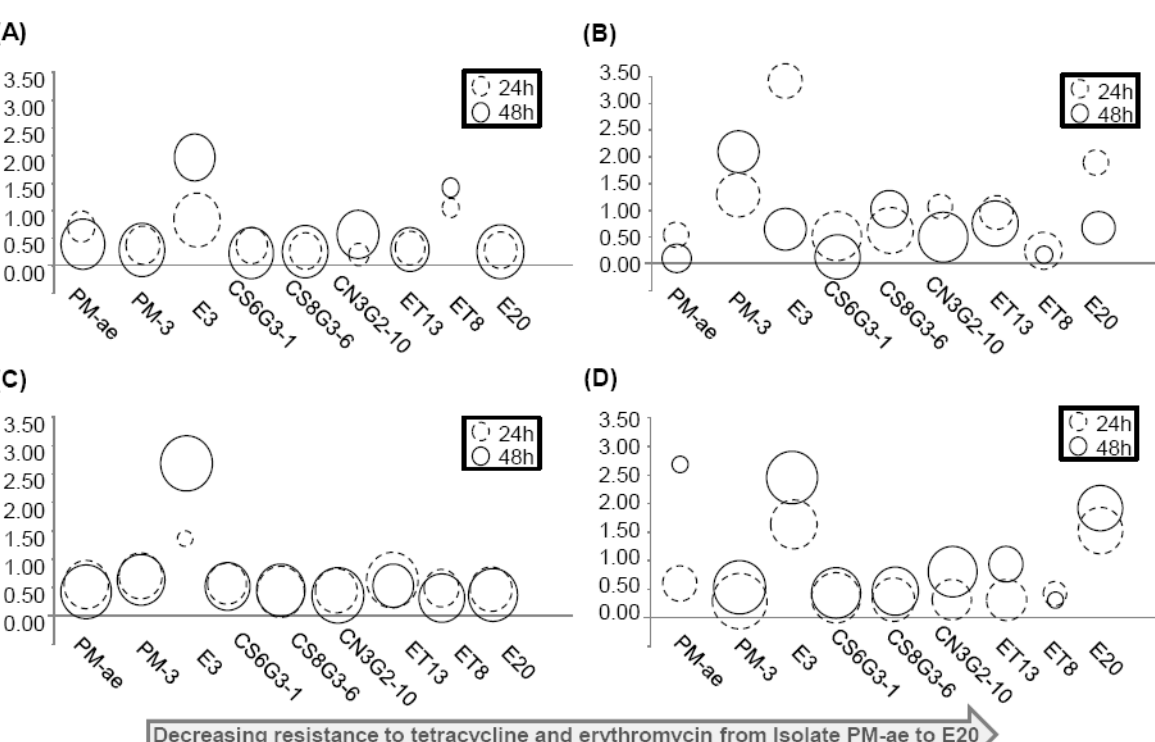
Figure 1. Bubble plots depicting the amount of attached biofilm formed by the individual bacterial isolate on the microtiter plate assay. The isolates were grown in ( A ) R2A, ( B ) TYG, ( C ) nutrient, and ( D ) Luria broth for 24 and 48 h. Isolates were arranged in order of their MICs towards tetracycline and erythromycin, in which PM-ae exhibited the highest MIC towards antibiotics, and vice versa for E20. The center of each bubble gives the value of attached biofilm biomass as quantified by crystal violet staining. The size of each bubble is a measure of cell density as quantified by OD 600